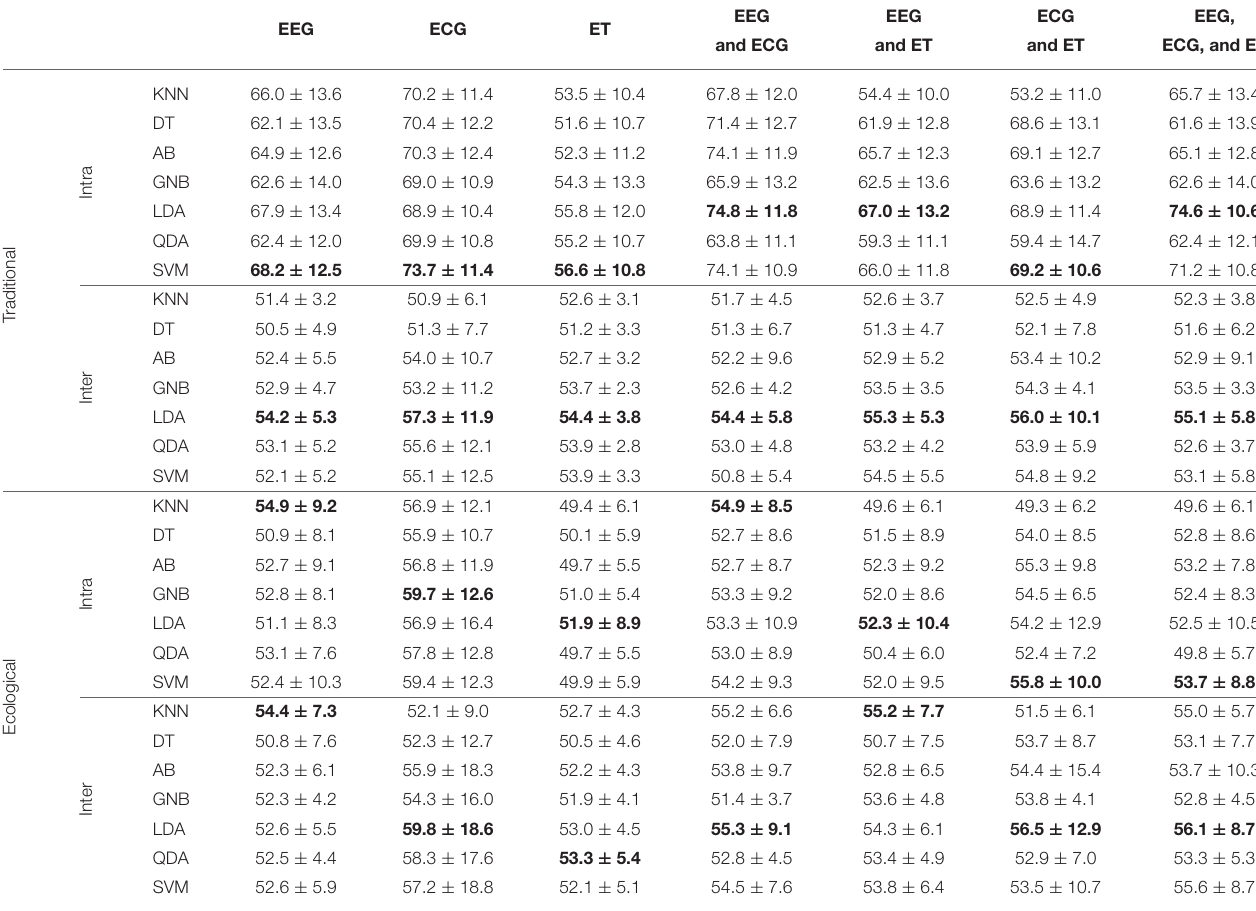
TABLE 1 | Comparison of different features and classifiers for traditional and ecological validation designs (mean accuracy and standard deviation).